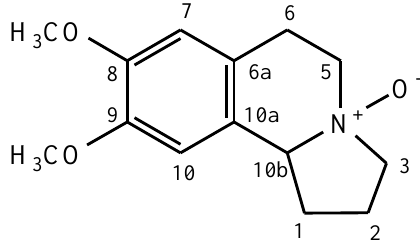
Figure 1. The structure of Crispine A N-oxide (8,9-dimethoxy-1,2,3,5,6,10b-hexahydro-pirrol- isoquinoline N-oxide)